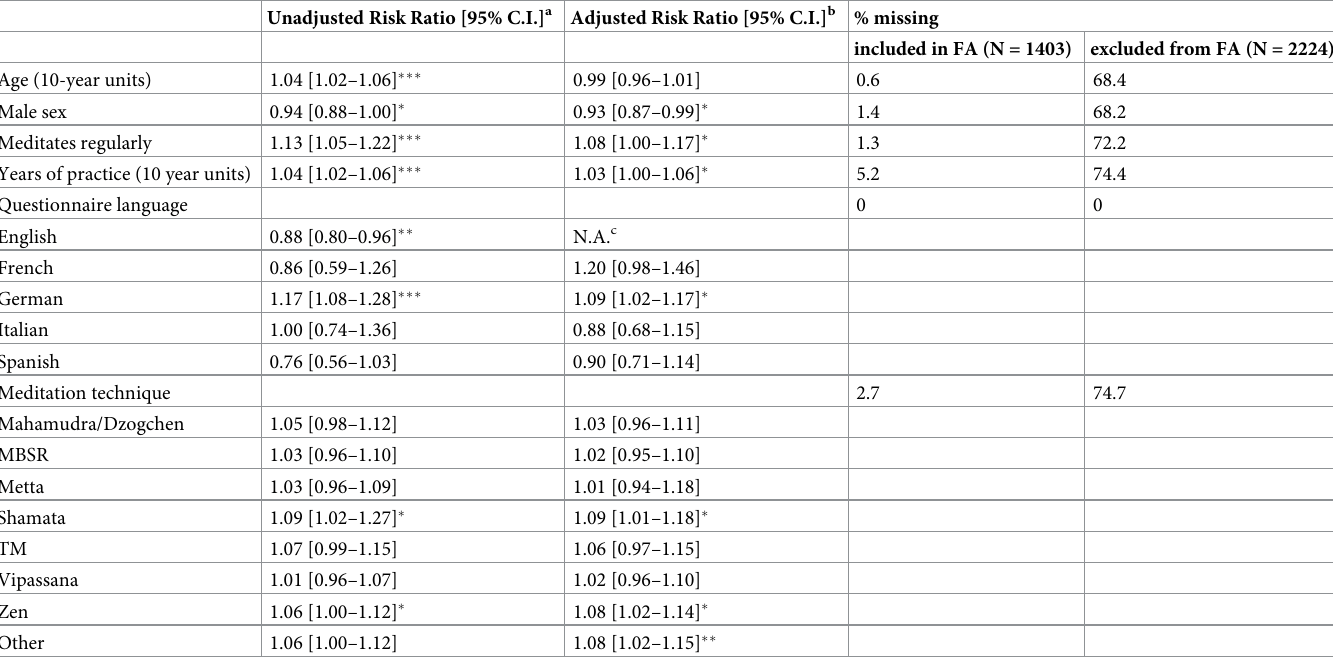
Table 4. Risk ratios comparing participants included (N = 1403) to those not included (N = 2224) in factor analysis.